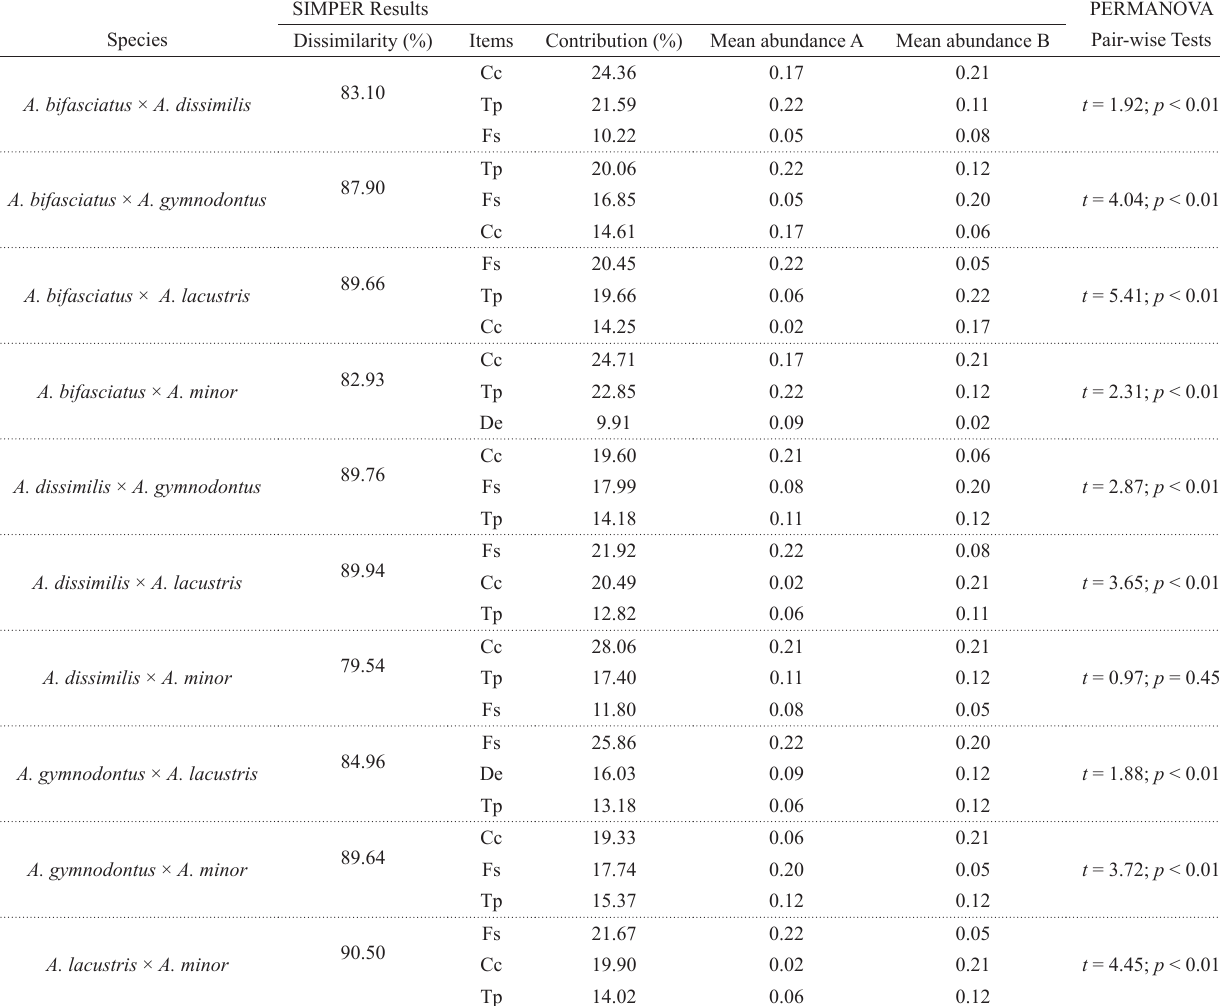
Fig. 2. Volumetric percentage of the origin of food items in the diet of Astyanax species in the Low Iguaçu River and tributaries in Brazil. Tab. 2. Dissimilarity of Astyanax species diet in Lower Iguaçu River and its tributaries in Brazil as verified by SIMPER and PERMANOVA ( pseudo - t ). Cc= Compsopogon caeruleus ; Tp=terrestrial plant; Fs=fruit/seed;